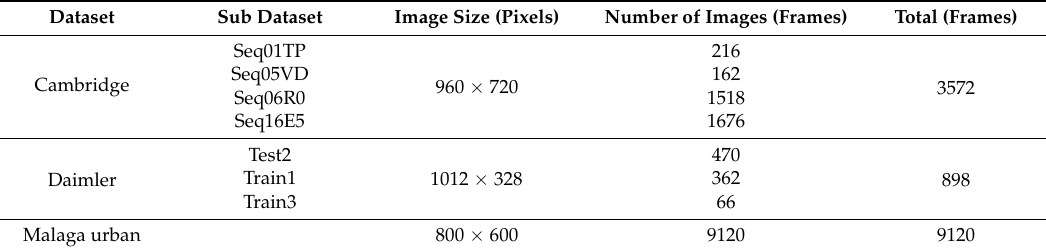
Table 3. Descriptions of each